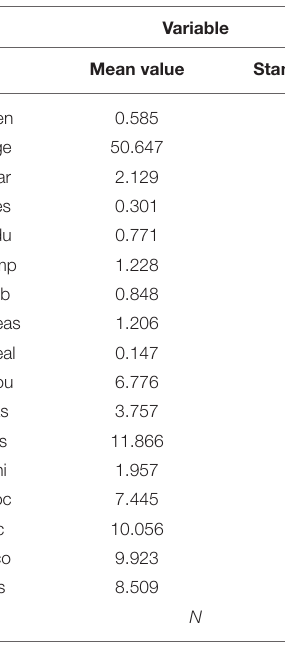
TABLE 2 | Summary